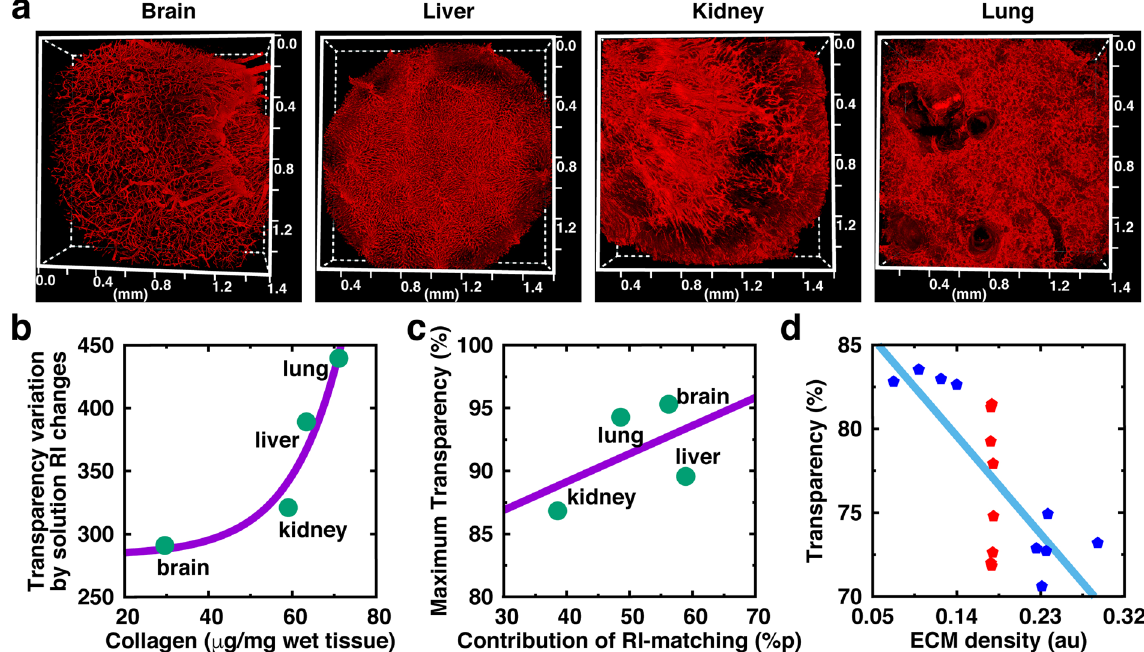
Figure 3. Evaluation of collagen IV and RI matching (a) Immunostained images of each organ with collagen IV, which is one of the main components for light scattering in tissues. (b) Correlation between the actual collagen amount and variation of transparency on different levels of RI-matching. Also see Suppl. Fig. 6. Average values of triplicated samples were used. (c) Maximum transparency of fully cleared tissue determined by contribution of RI-matching (ECM). (d) Finite-difference time-domain (FDTD) simulation with randomly generated images of various ECM density showing that light transmittance is dependent on ECM density (from negative slop of the linear fitting line) and ECM structures (from red points having similar ECM